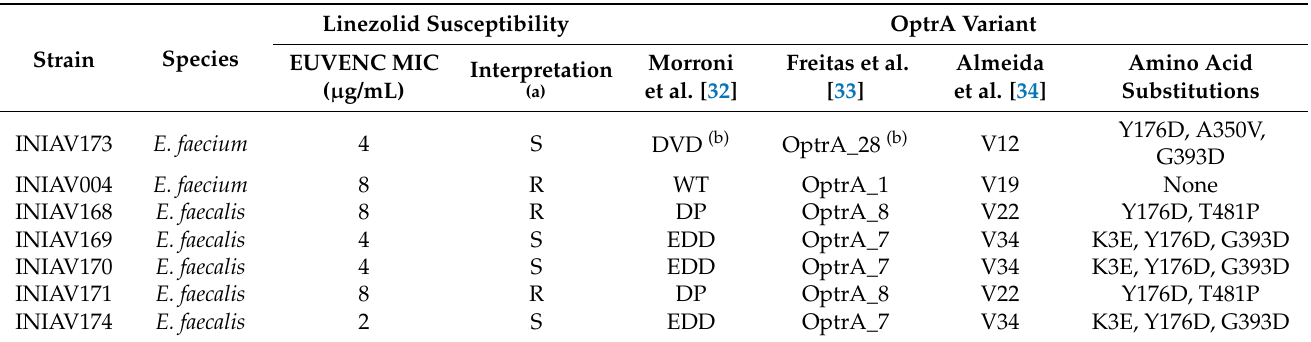
Table 2. OptrA variants and linezolid MICs detected among E. faecium ( n = 2) and E. faecalis ( n = 5) isolates from